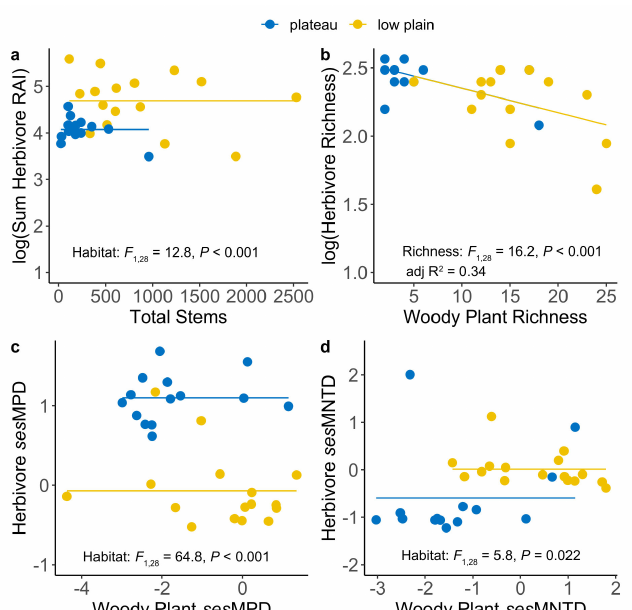
Figure 2. Abundance and diversity of ( a – d ) woody plants and ( e – h ) large herbivores across habitats (mean ± s.e.). Letters above each bar indicate significant differences based on Tukey’s HSD following ANOVAs. Abundance is the ( a ) total plant stems/site and ( e ) total herbivore RIA/site. Richness is the mean count of ( b ) woody plant and ( f ) large herbivore species. Phylogenetic diversity was measured as ( c , g ) ses MPD and ( d , h ) ses MNTD, with positive values indicating overdispersion and negative values clustering.